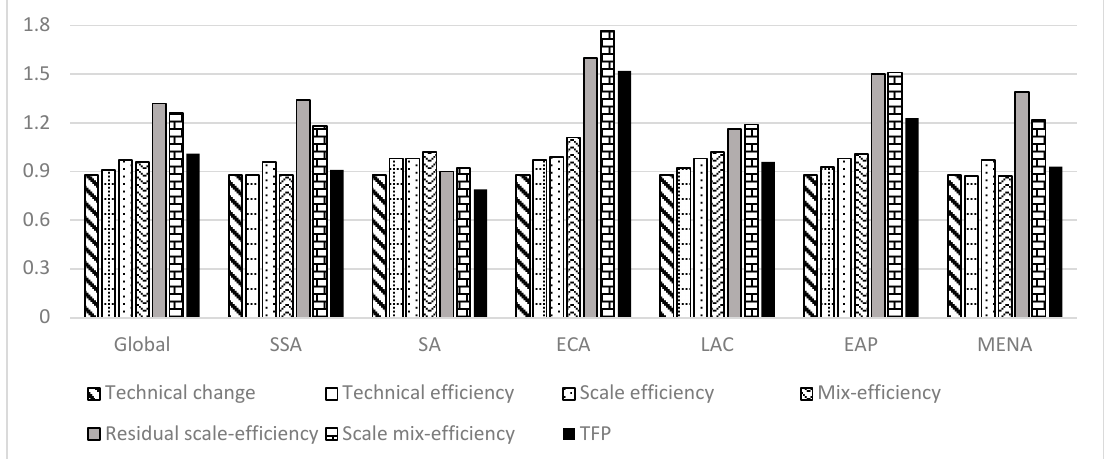
Figure 4. Geomean of TFP and its components.